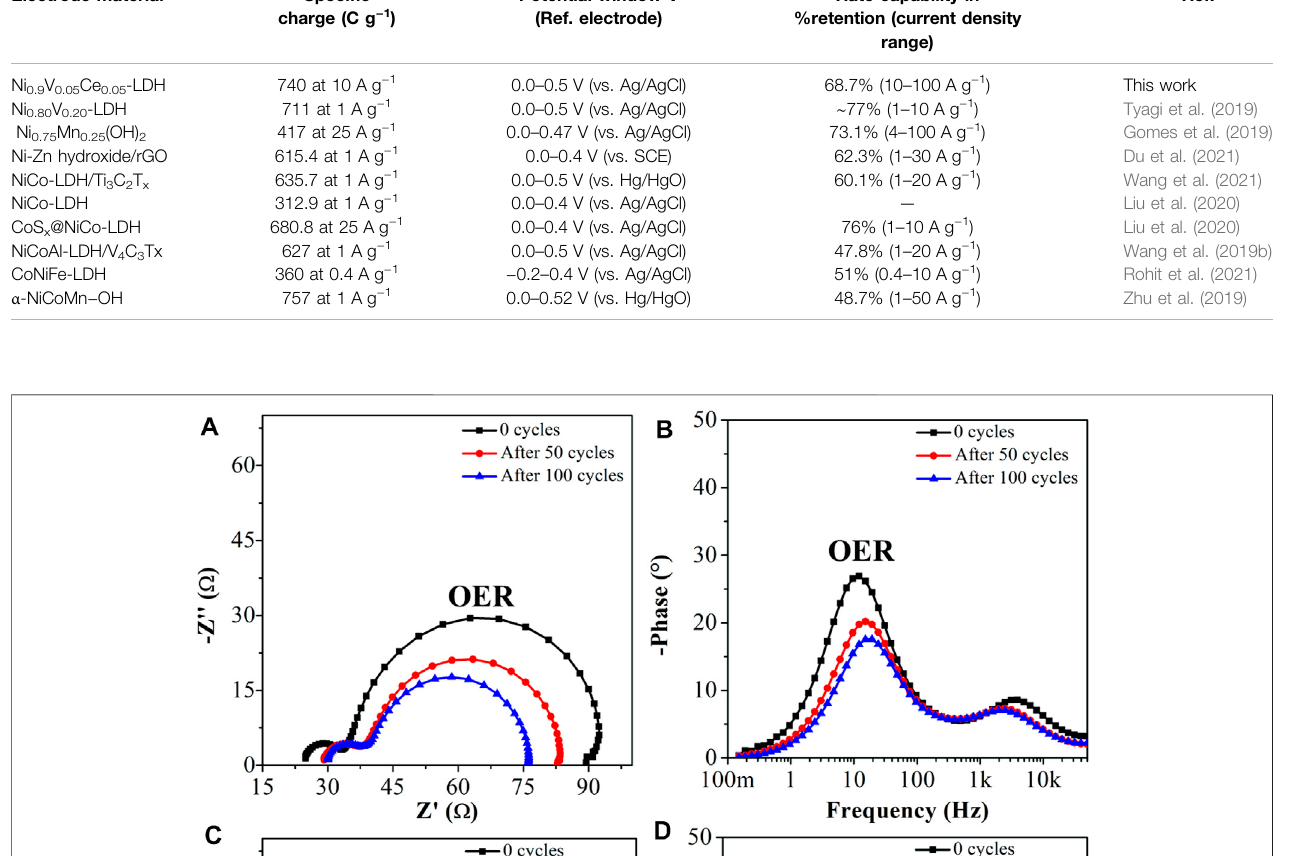
TABLE 1 | Comparison of pertinent electrochemical parameters of bi- and trimetallic metal hydroxide-based materials and their performance as cathode material. Electrode material